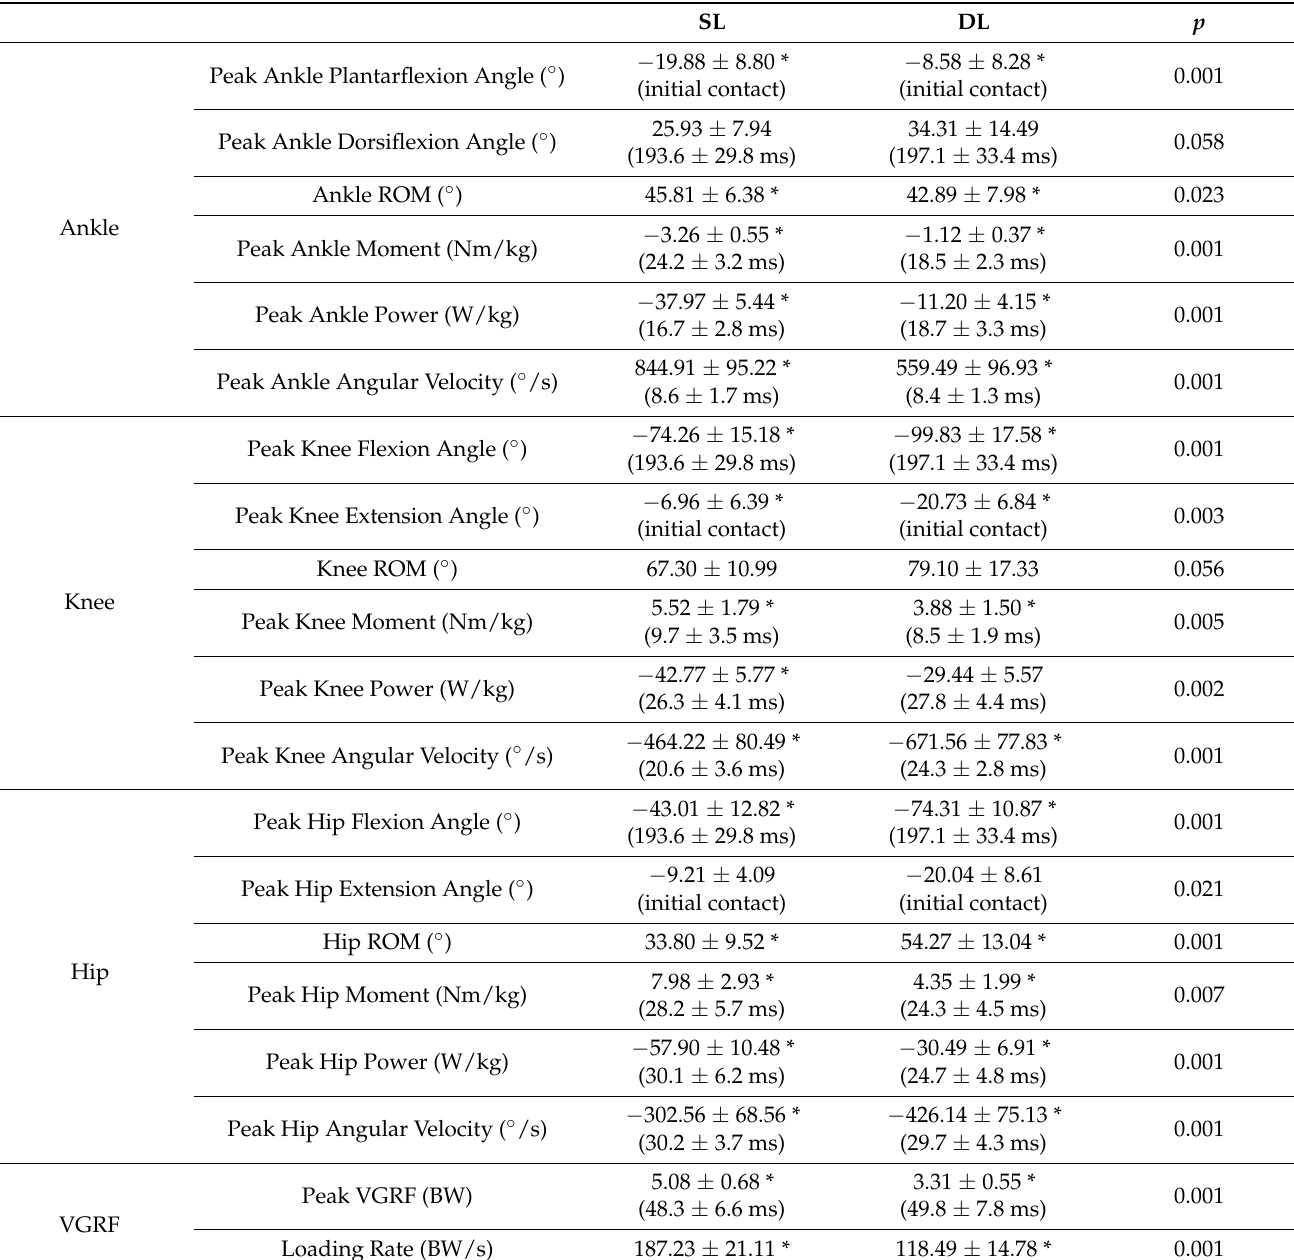
Table 1. Means ± standard deviations for the peak angle moment power and angular velocity of ankle knee and hip sagittal plane, peak VGRF and loading rate between SL and